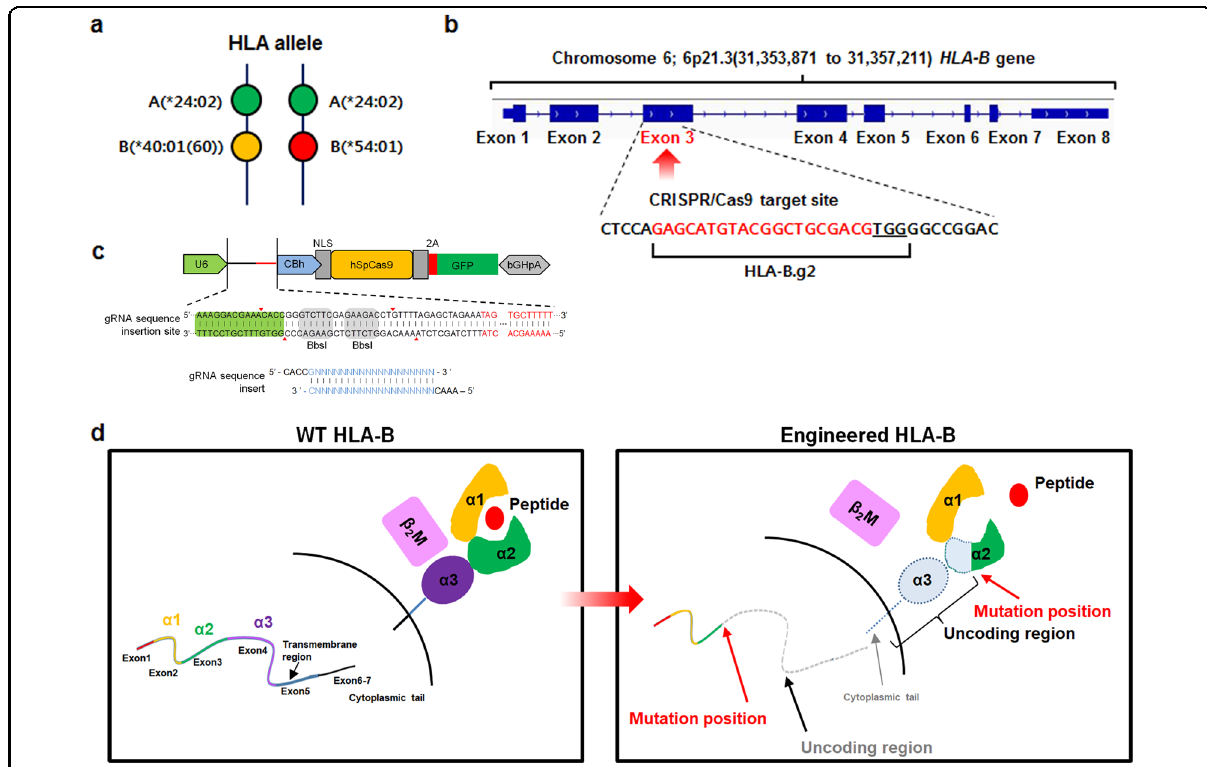
Fig. 1 A strategy for developing immunocompatible stem cells using the CRISPR/Cas9 system. a HLA allelic type of iPSCs used for immunocompatible cell development. b gRNA-targeted gene locus and sequence for HLA-B engineering. HLA-B.g2 (gRNA) was designed to target an exon of the HLA-B gene. c The vector map of the HLA-B.g2 plasmid. d Predicted region of the HLA-B protein deleted by the CRISPR/Cas9